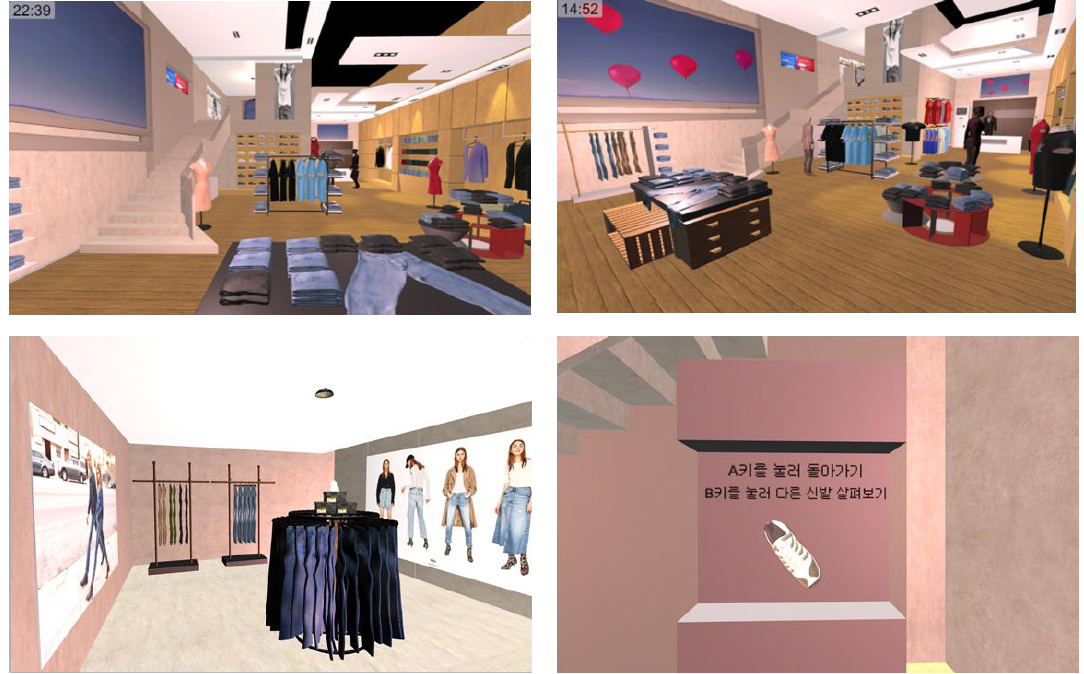
Figure 8. Virtual space (Commercial facility). First three photos show the virtual space in different angles, and the last photo shows a shoe to be chosen by the user.